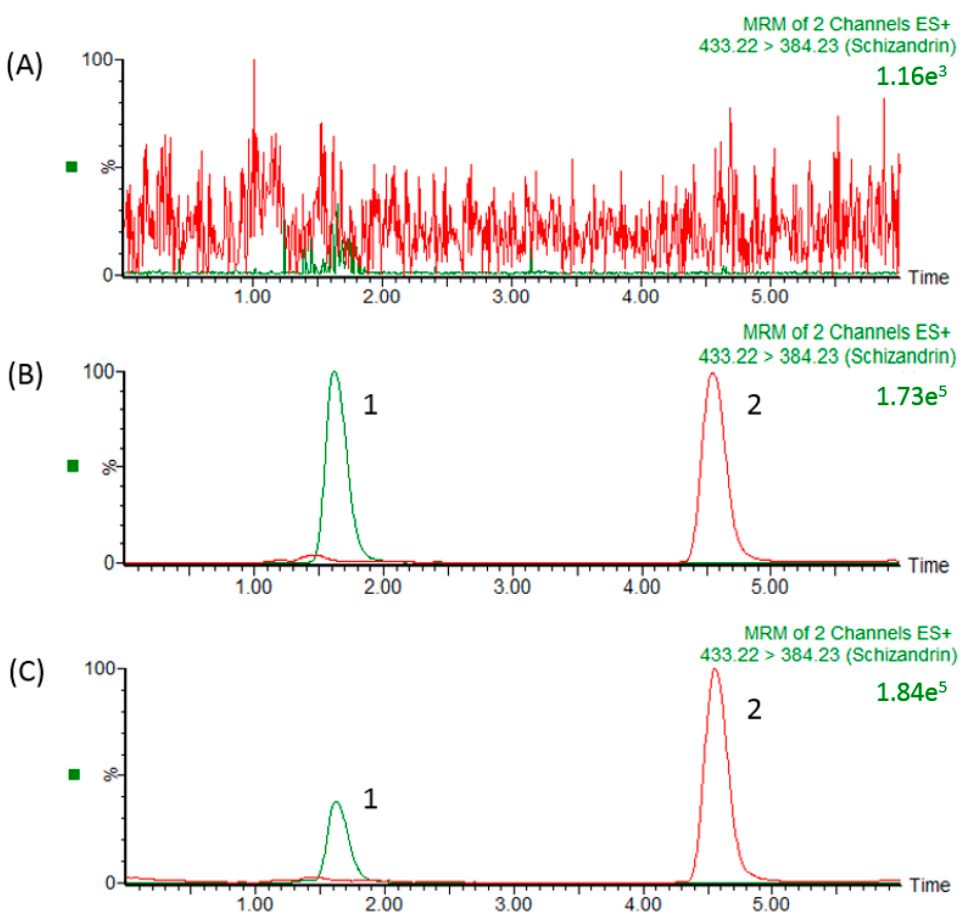
Figure 2. HPLC chromatograms ( A ) Blank plasma; ( B ) schizandrin standard (100 ng/mL) RT: 1.6 min; and ( C ) plasma sample collected from the jugular vein of a rat at 15 min after schizandrin (31.8 ng/mL) administration (10 mg/kg, i.v.). 1: Schizandrin; 2: methyl yellow (internal standard).